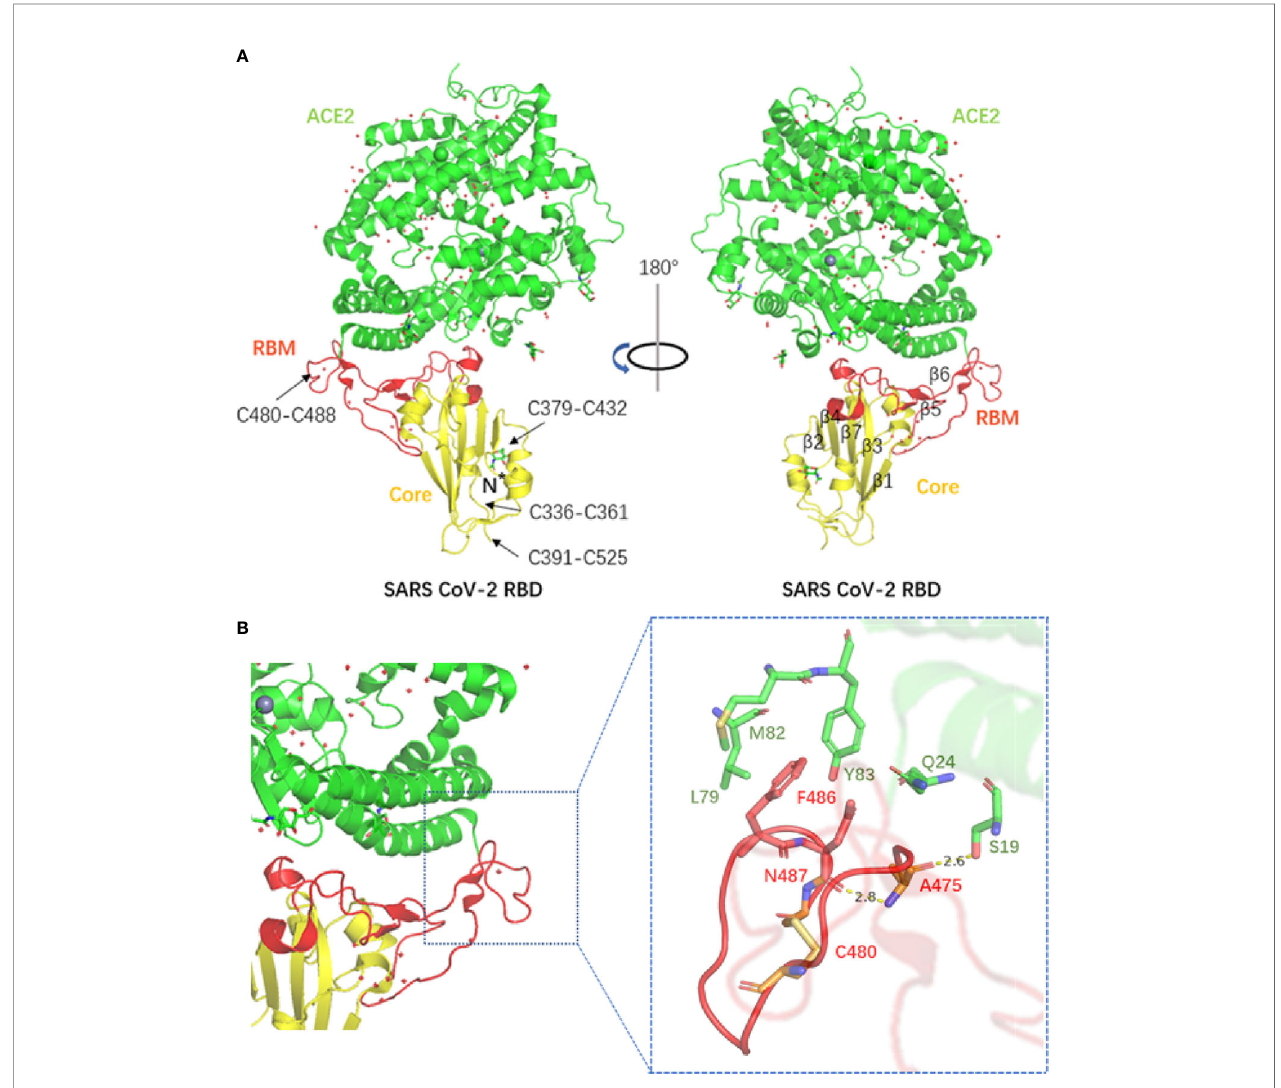
FIGURE 3 | (A) The structure of the SARS-CoV-2 RBD complex bound to ACE2. Disulphide bonds in the SARS-CoV-2 RBD are indicated by arrows (PDB accession number: 6 M0J). (B) The structure of the SARS-CoV-2 chimeric RBD complexed with hACE2. The hydrogen bond as well as parts of the interactions are shown in the fi gure (PDB accession number: 6